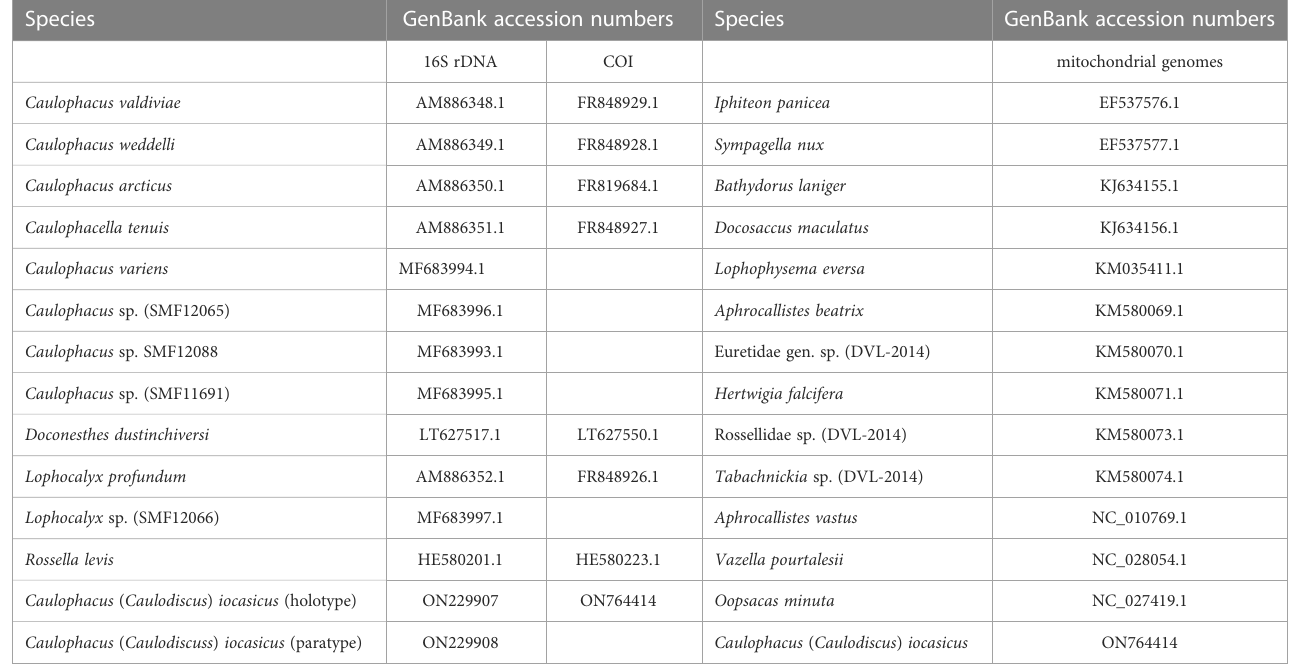
TABLE 2 16S rDNA, COI, and mitochondrial genome sequences used in this